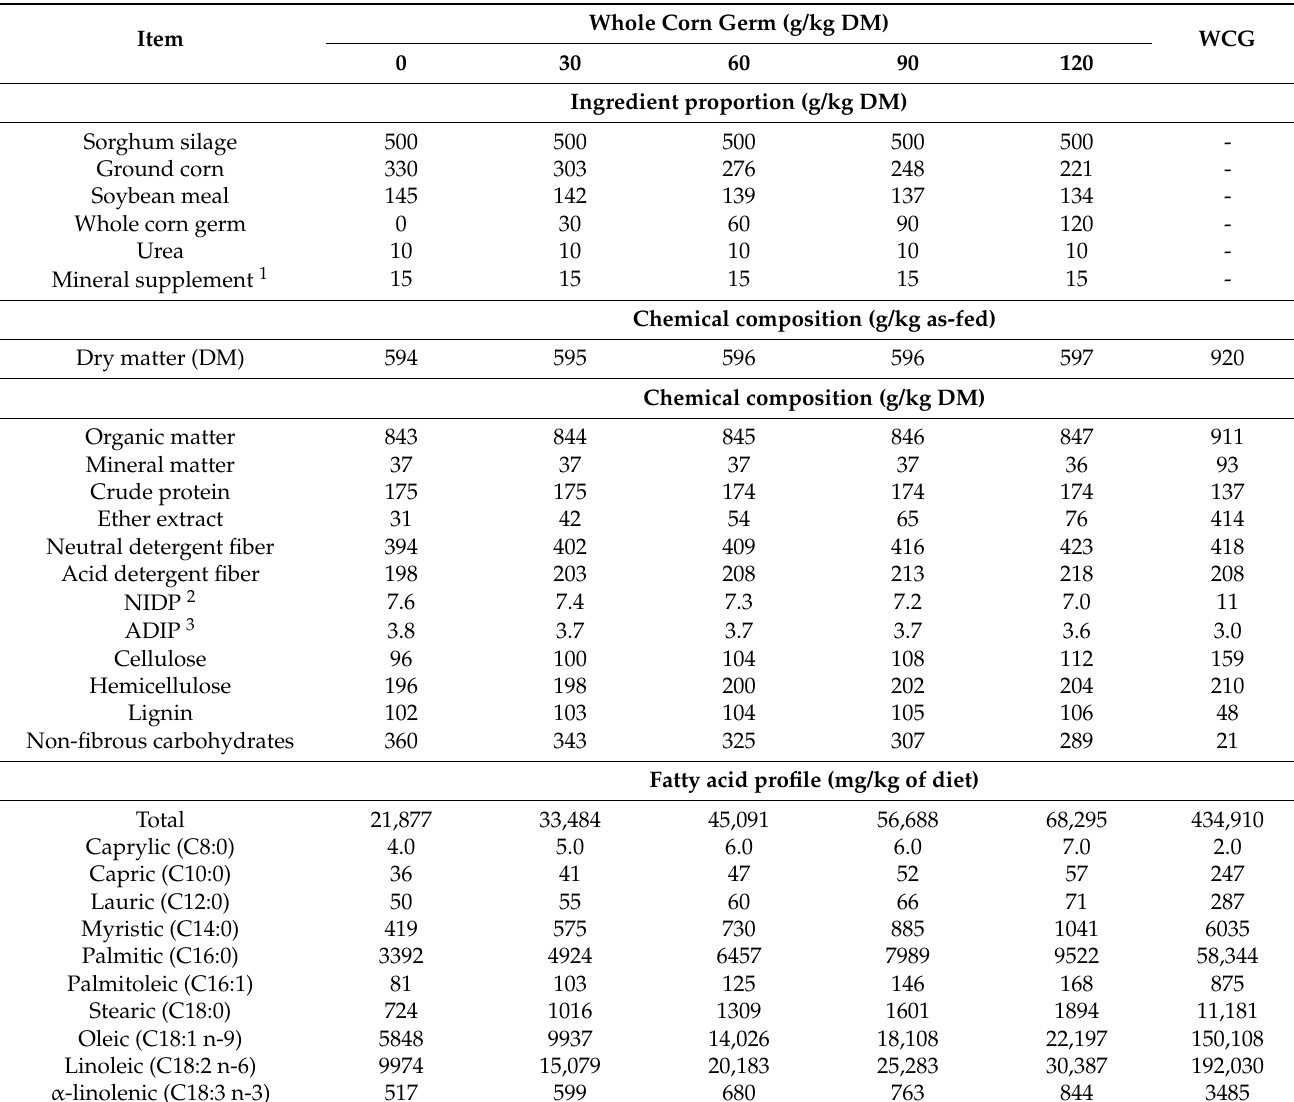
Table 1. Proportion of ingredients, chemical composition, and fatty acid profile of the experimental diets and whole corn germ